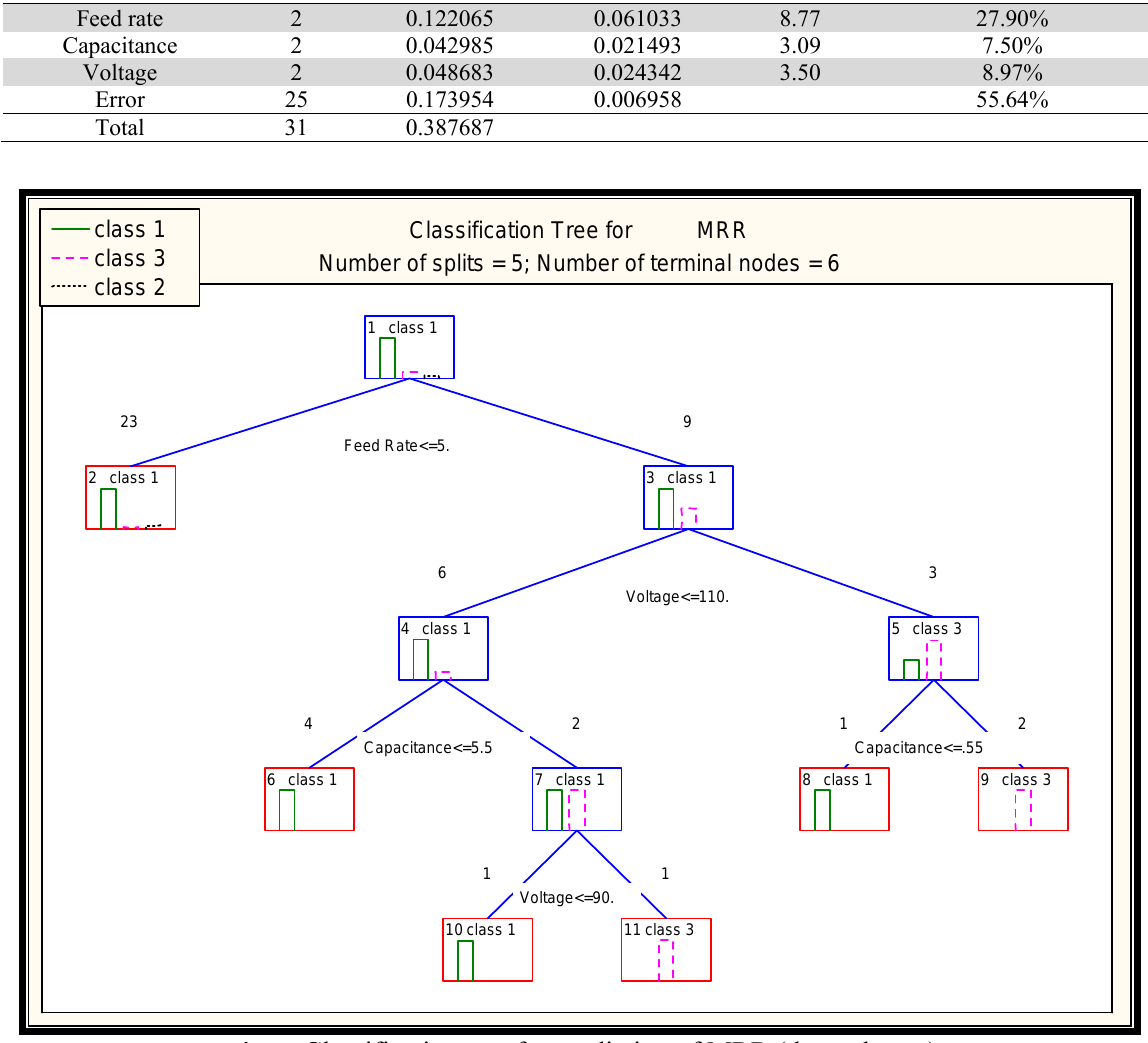
Fig. 6. Classification tree for prediction of MRR (three